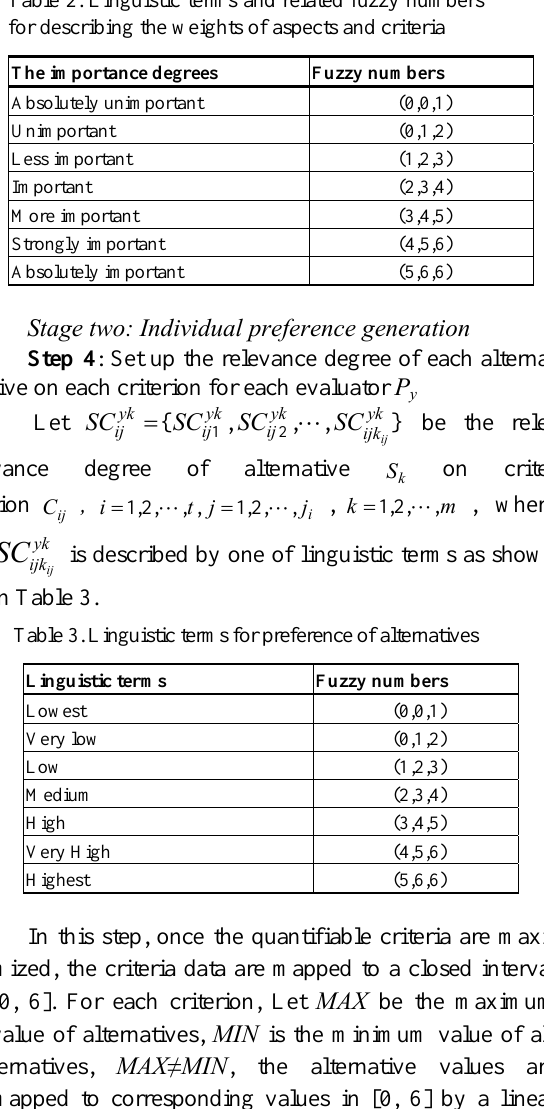
Table 2. Linguistic terms and related fuzzy numbers